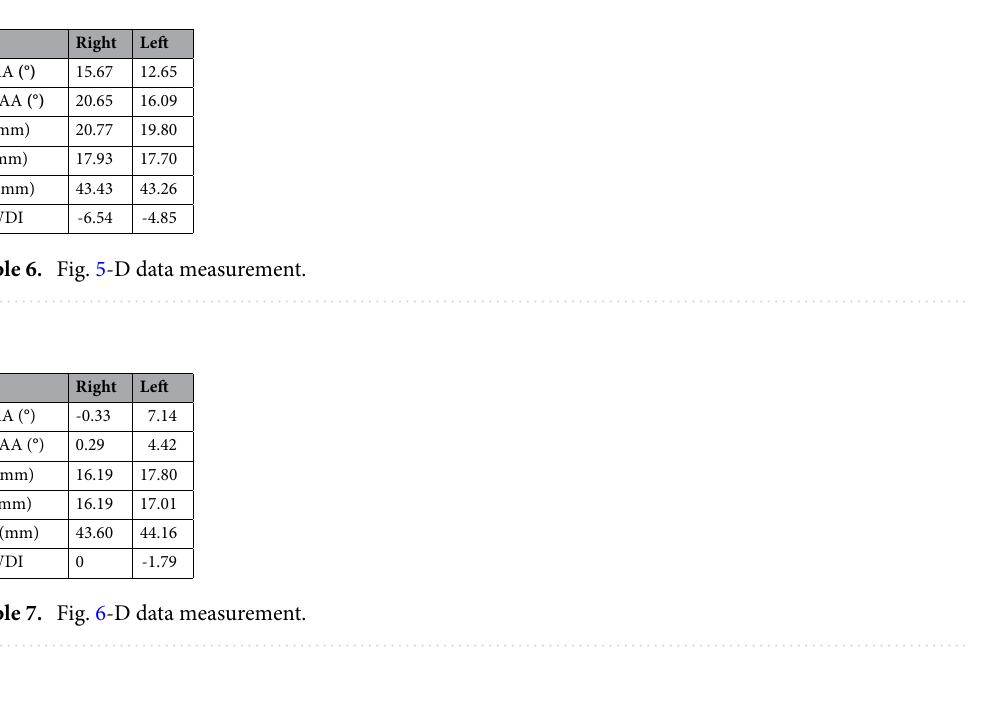
Figure 6. An eight-year-old boy with Legg-Calve-Perthes disease in the right hip. The anteroposterior pelvis radiograph ( A ), Von-Rosen pelvis radiograph ( B ) and frog pelvis radiograph ( C ) show that patient was in Waldenstrom II stage, Herring B stage and Catterall III stage.